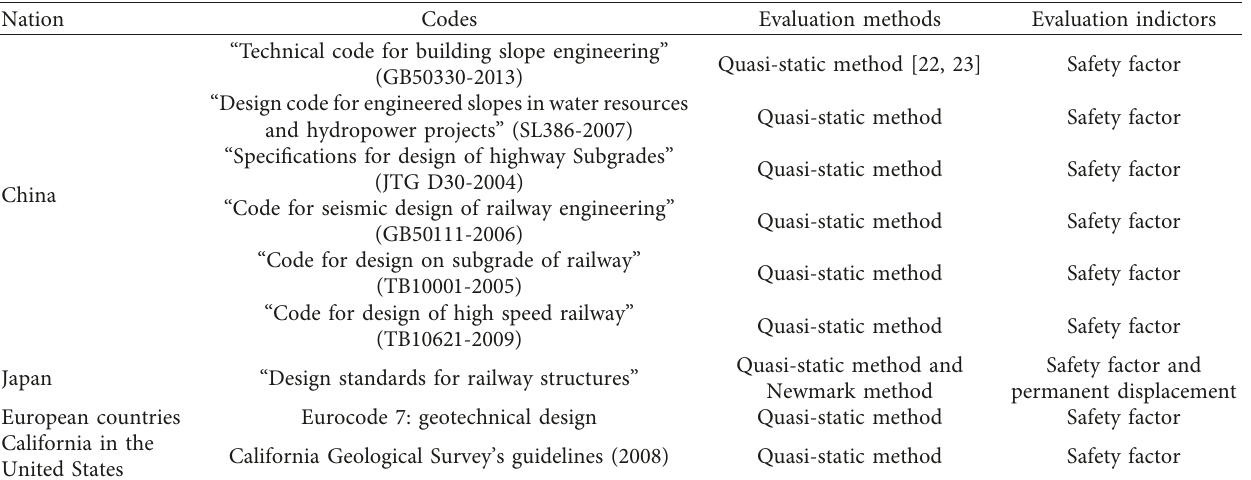
Table 2: Slope codes of the earthquake-prone